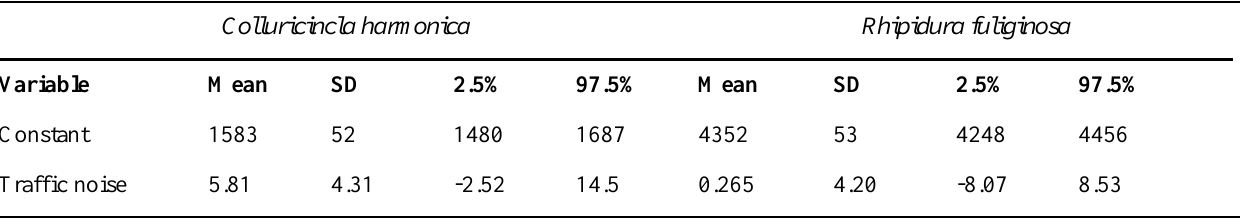
Table 1. Coefficients (mean, SD, and 2.5th and 97.5th percentiles) of the variables included in the models of song frequency (dominant frequency of the lowest tonal note) as a function of traffic